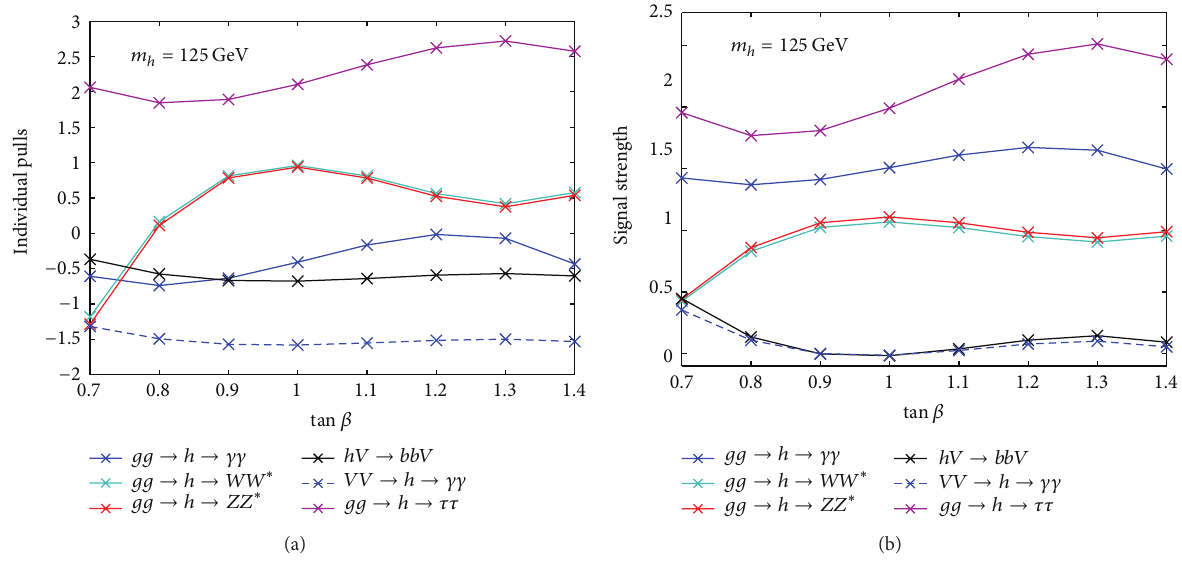
Figure 25: The individual pulls (𝑅 Model 𝑋𝑋 − 𝑅 Obs 𝑋𝑋 )/𝜎 𝑋𝑋 (a) and the signal strengths 𝑅 Model 𝑋𝑋 (b), in the different channels, that correspond to the best fitted 4G2HDMI curve with 𝑚 ℎ = 125 GeV and 𝑀 4𝐺 = 400 GeV, shown in Figure 24. Figure taken from